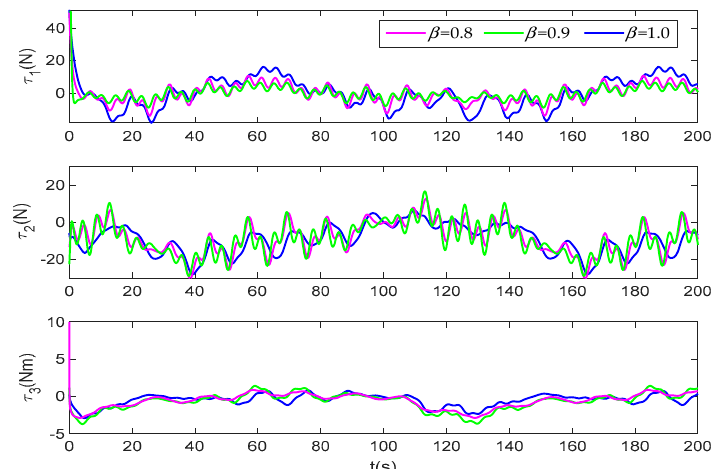
Figure 20. Control input under different orders.